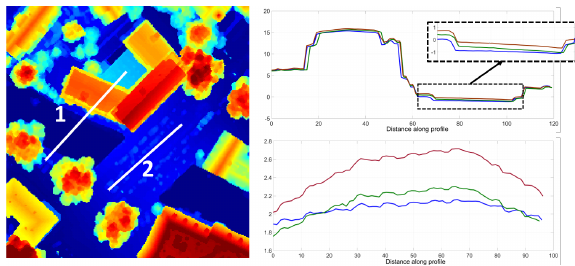
Figure 4. Mask T derivation based on DTM computation using L 1 spline (left) and L 2 spline (middle) interpolation and Gridfit method (right).